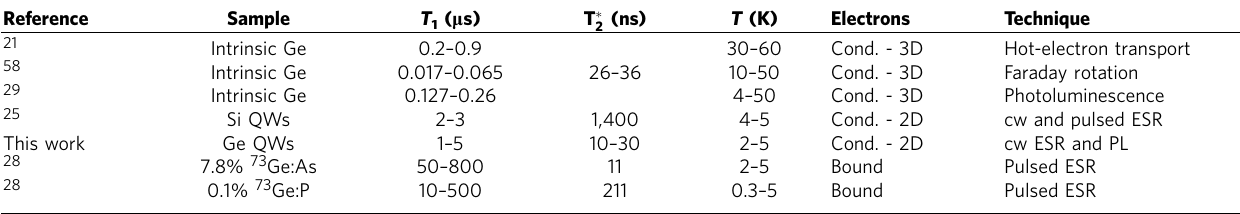
Table 2 | Spin relaxation and dephasing times for electrons in